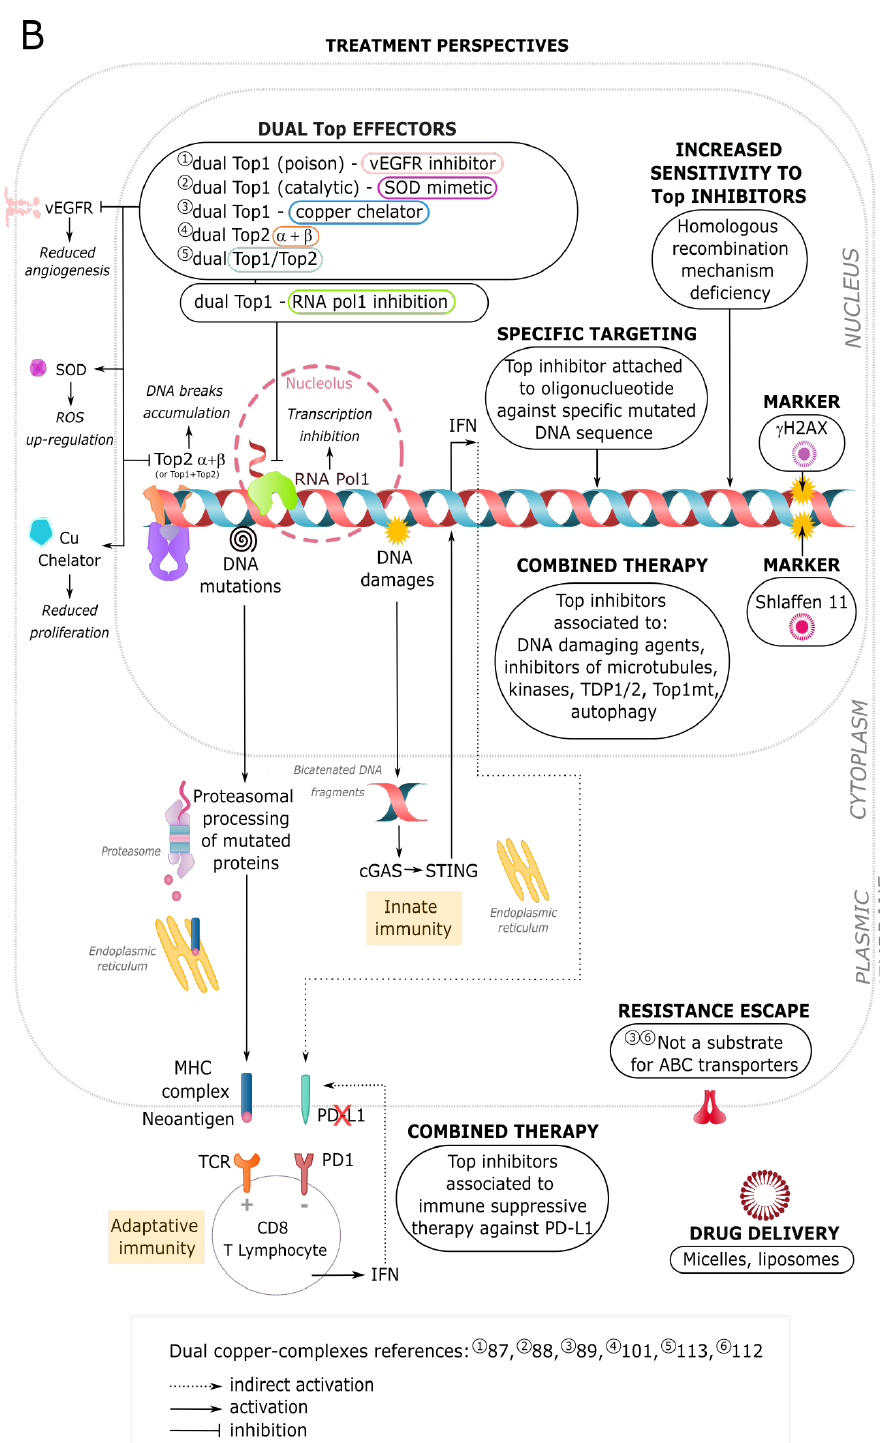
Figure 5. Molecular mechanisms and treatment perspectives for copper complexes (CuC) drugs. (A) Molecular checkpoints and networks involved in DNA damage (red), cell cycle regulation (yellow), and death response (violet) triggered by topoisomerase inhibitors (poison and catalytic), including CuC of topoisomerase inhibitors. (B) Treatment perspectives alone or in association with other chemotherapeutics (see text for more details).